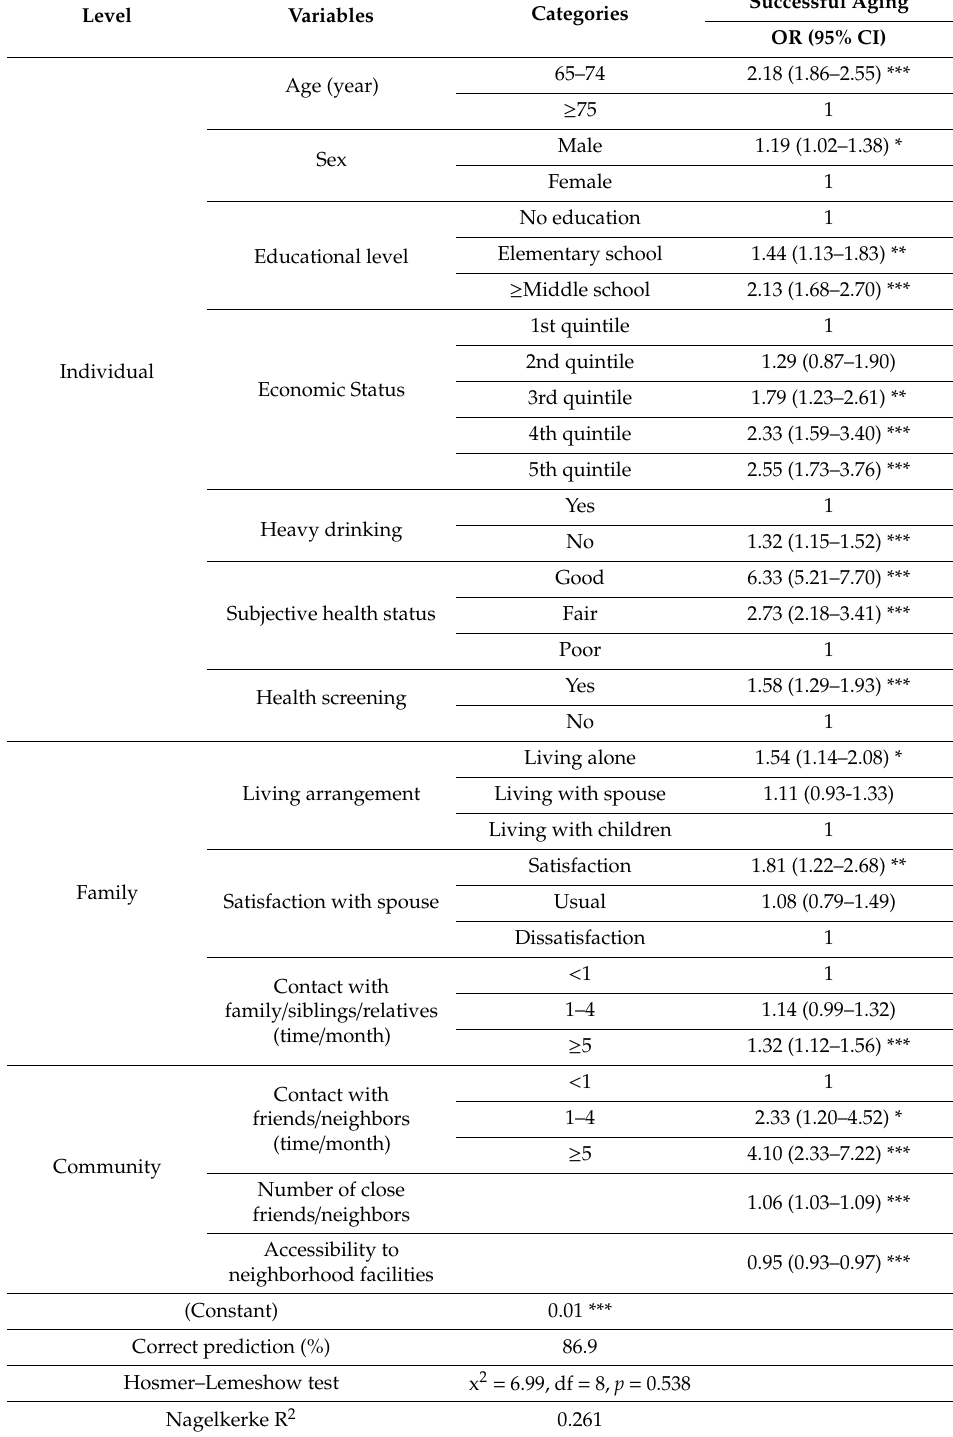
Table 4. Logistic Regression for Successful Aging related Variables, N =